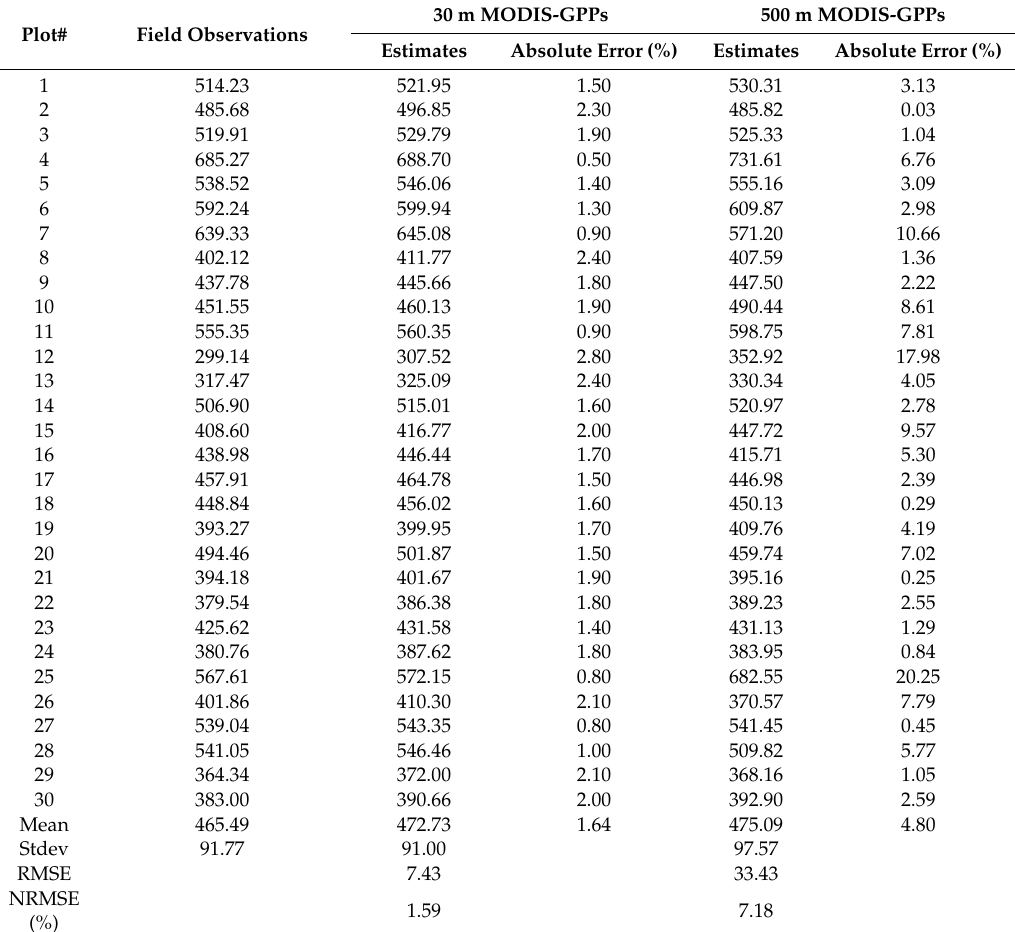
Table 2. Comparison of the original 500 m spatial resolution MODIS-GPPs from the 289th day in 2013 with their downscaled 30 m products by the Empirical Bayes Kriging (EBK) method based on the dry biomass field observations of 30 sample